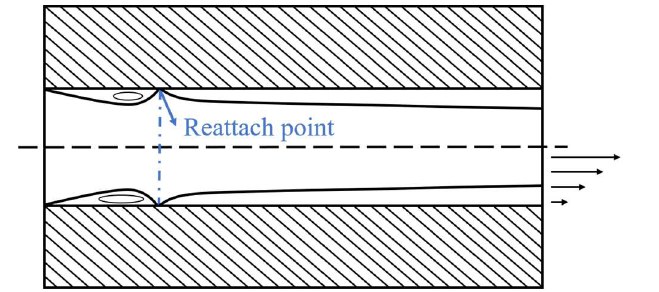
Figure 2. Turbulence.